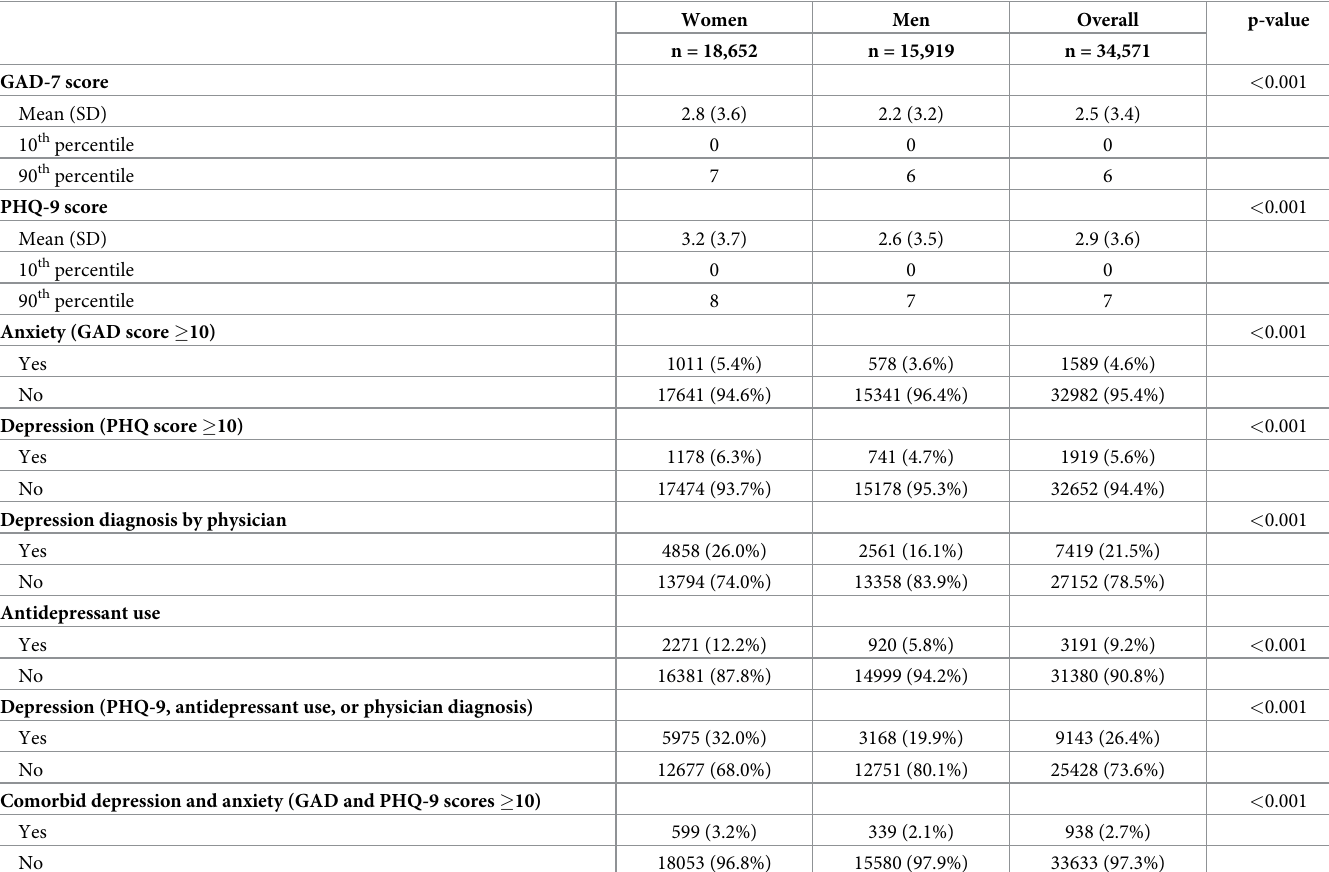
Table 3. Mental health characteristics of the CARTaGENE sample by sex at